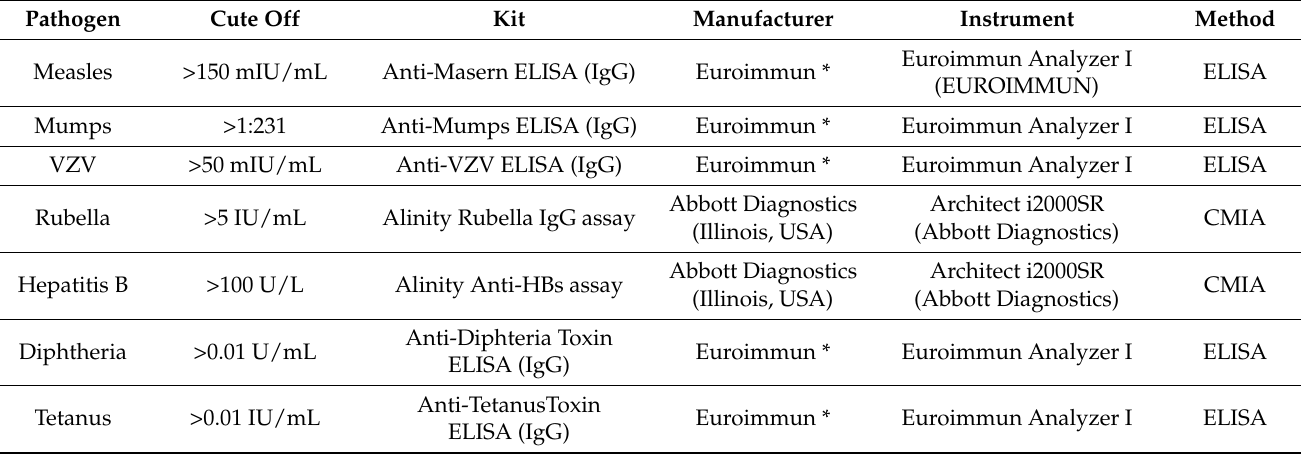
VZV = varicella zoster virus; ELISA = enzyme-linked immunosorbent assay; CMIA = chemiluminescent microparticle immunoassay. * EUROIMMUN Medizinische Labordiagnostika AG, Lübeck,